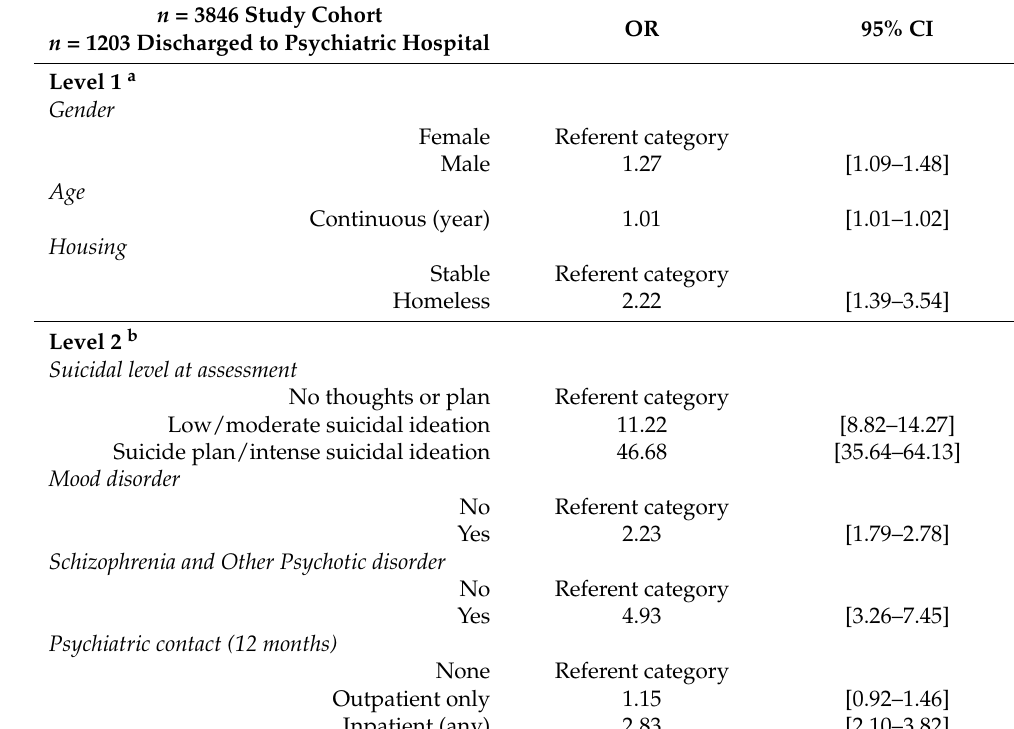
Table 3. Stepwise Logistic Regression Model for Discharge to Psychiatric